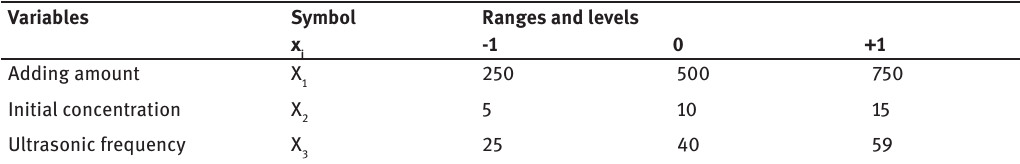
Figure 8: (A): Effect of the sunlight and physical adsorption on the degradation by Fe-doped TiO reaction in the sunlight, b: the reaction in the dark, c: the adsorption amount test of dye on Fe-doped TiO degradation of MO in aqueous solution. Table 2: Experimental ranges and levels of the